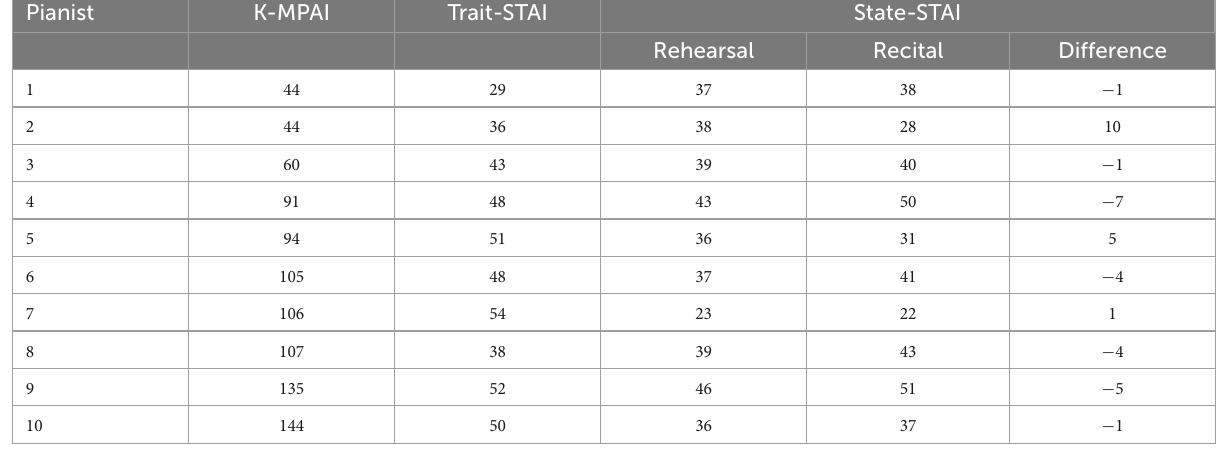
TABLE 1 Pianists’ kenny-music performance anxiety inventory (K-MPAI) and STAI scores.